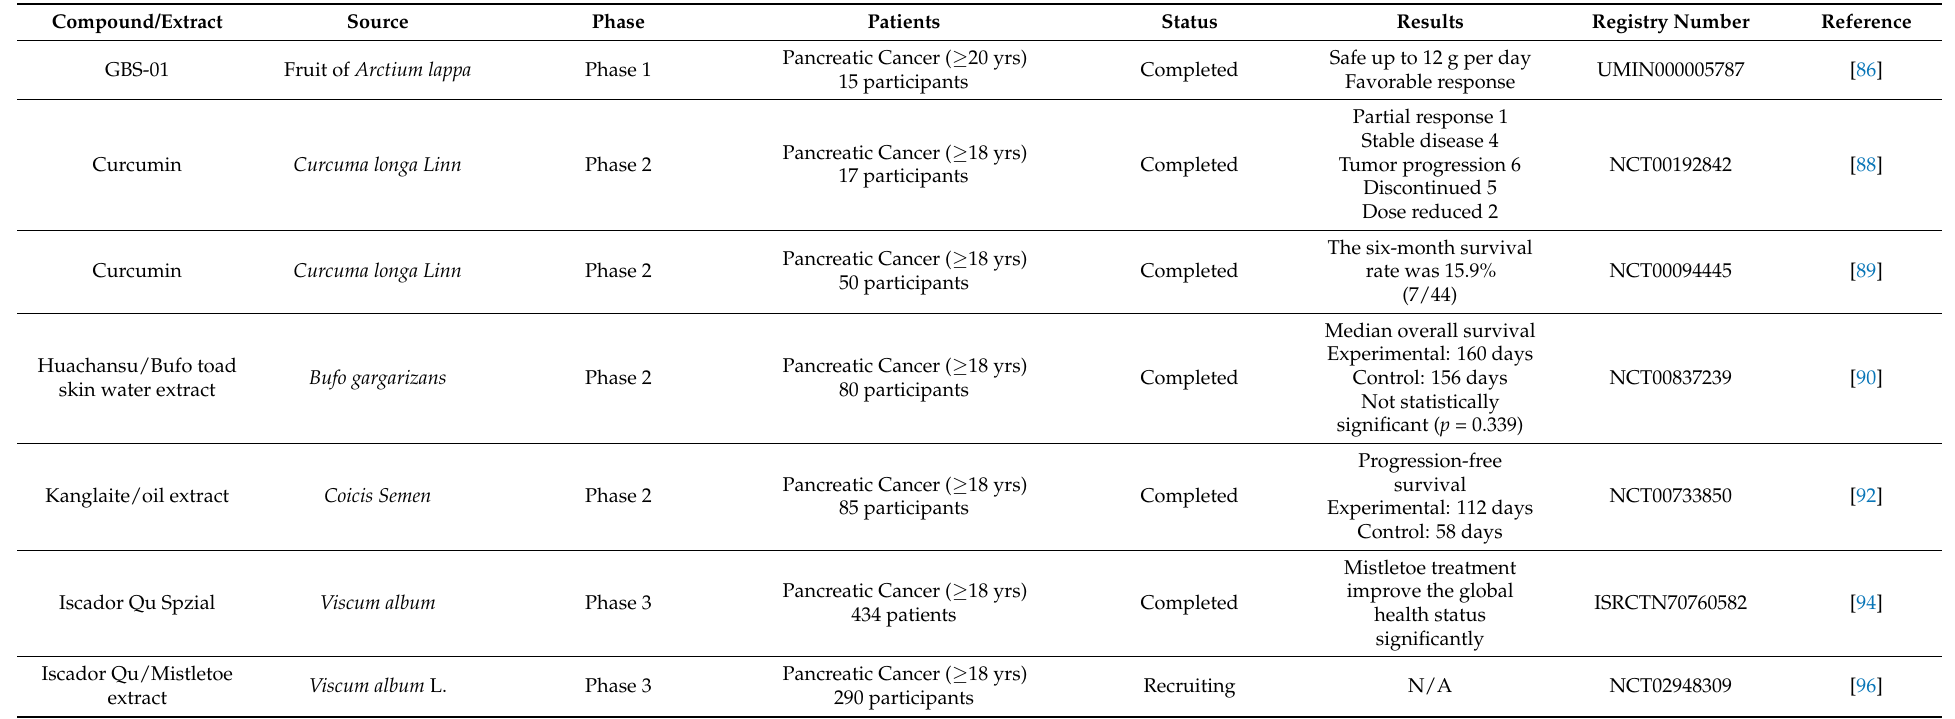
Table 7. Clinical trials of natural products against pancreatic